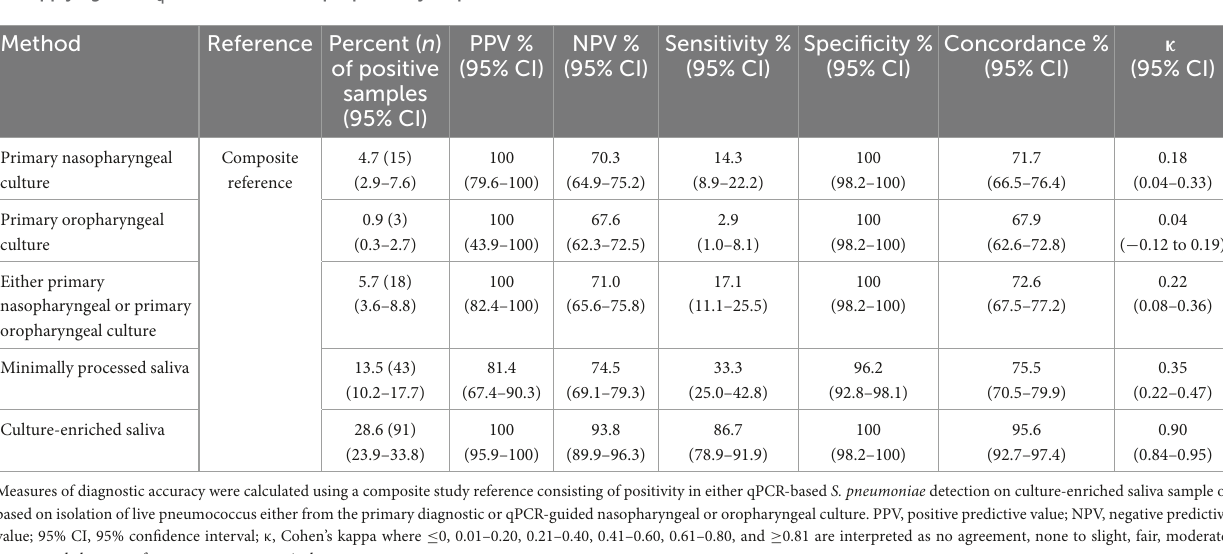
TABLE 3 The accuracy of Streptococcus pneumoniae detection of serotypes in paired nasopharyngeal, oropharyngeal, and saliva samples from n = 318 adults in the Netherlands tested using molecular methods applied to DNA extracted from minimally processed and culture-enriched samples and applying ROCd C q thresholds for sample positivity in qPCRs.